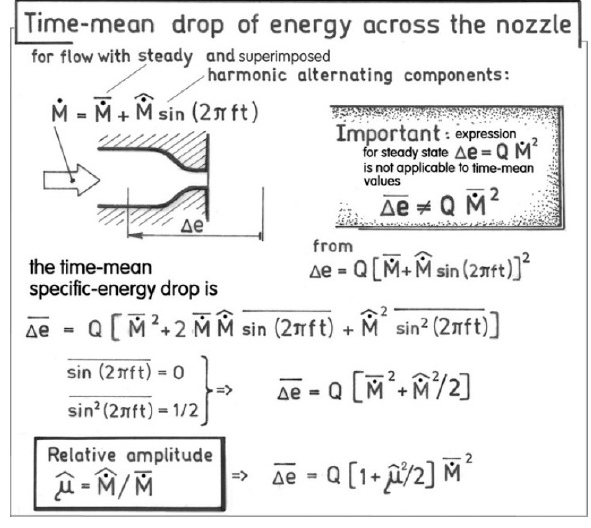
Fig. 15. Because of non-linearity of the nozzle characteristic, superposition of periodic pulsation (here the simple harmonic alternating flow) results in the nozzle behaving as if its time- mean dissipance